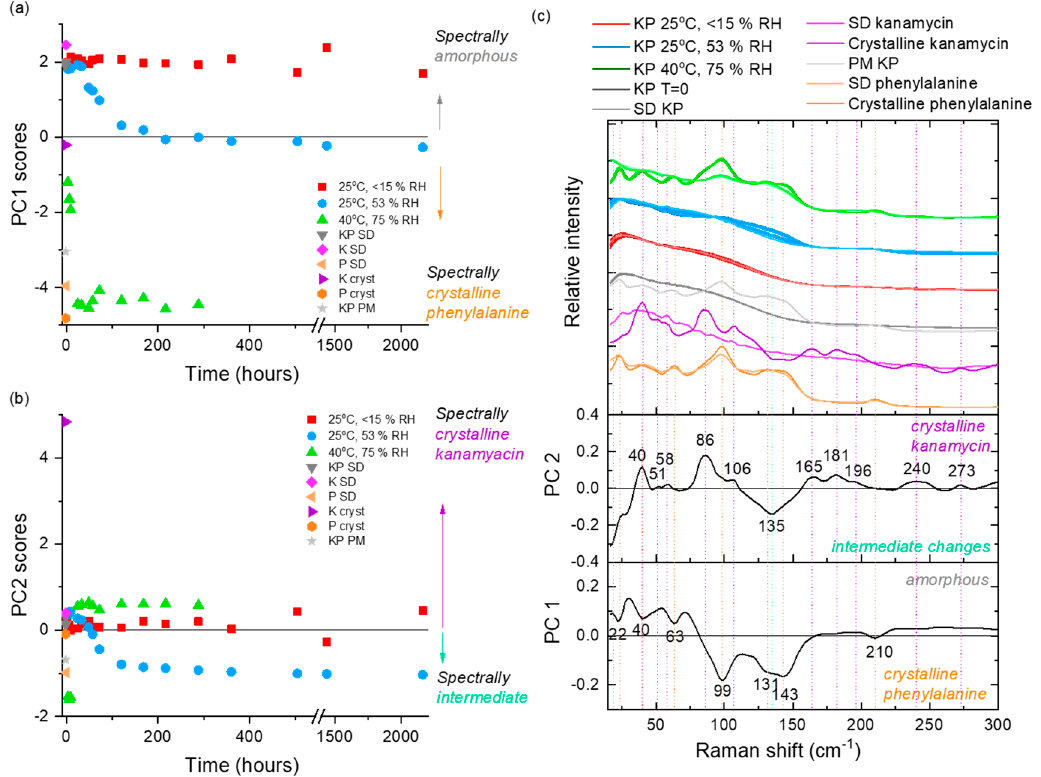
Figure 6. PCA analysis of the LFR spectra collected from KP samples stored under three different conditions (25 ◦ C /< 15% RH, 25 ◦ C / 53% RH and 40 ◦ C / 75% RH) over time. ( a ) PC 1 scores versus time, ( b ) PC 2 scores versus time, and ( c ) the associated loadings with comparative spectra. PM represents a physical mixture of amorphous kanamycin and crystalline phenylalanine in a 1:1 molar ratio. PC 1 accounts for 83% of the explained spectral variance, and PC 2 accounts for a further 11% explained variance. Spectra from the different storage conditions in ( c ) have slight color graduations to highlight early (lighter coloring) versus latter (darker coloring) time points.